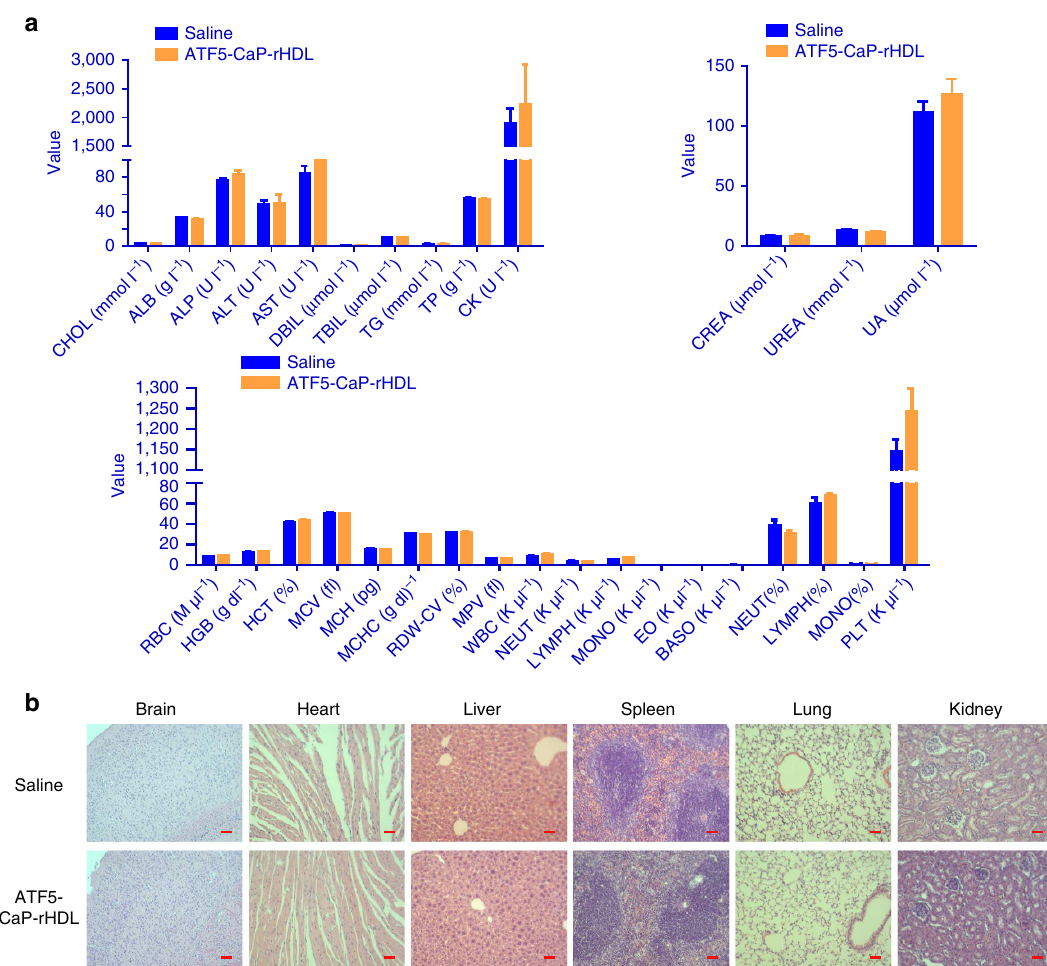
Figure 10 | Evaluation of the safety of ATF5-CaP-rHDL on healthy ICR mice. Healthy ICR mice were i.v. administered with saline or ATF5-CaP-rHDL